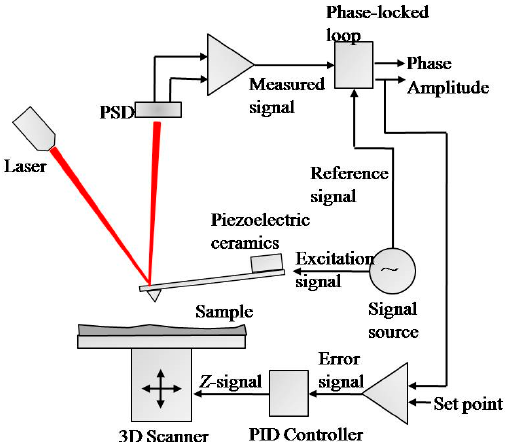
Figure 3. Structure of the experimental system. (PSD: Position Sensitive Detector; PID controller: Proportion Integration Differentiation controller.)